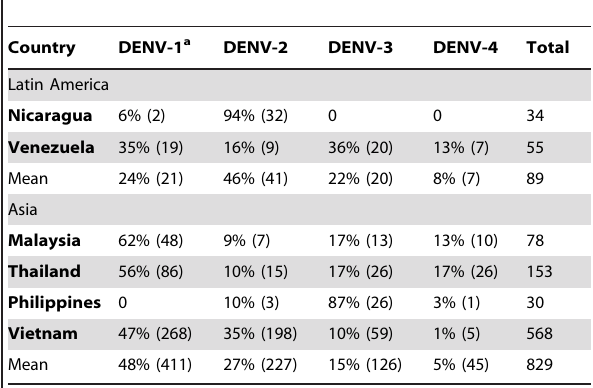
Table 4. Geographical and serotype stratification of the study